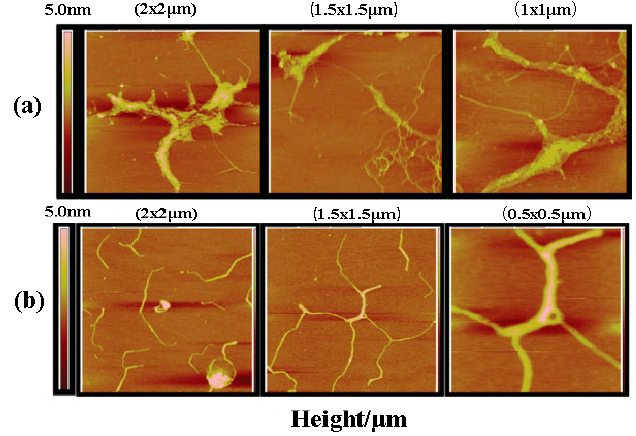
Figure 3. The AFM topology graph of Pleurotus geesteranus β - D -glucan at different magnifications at 4 °C ( a ) and 22 °C ( b ) (reproduced from [18] with permission from John Wiley and Sons, Copyright 2009).